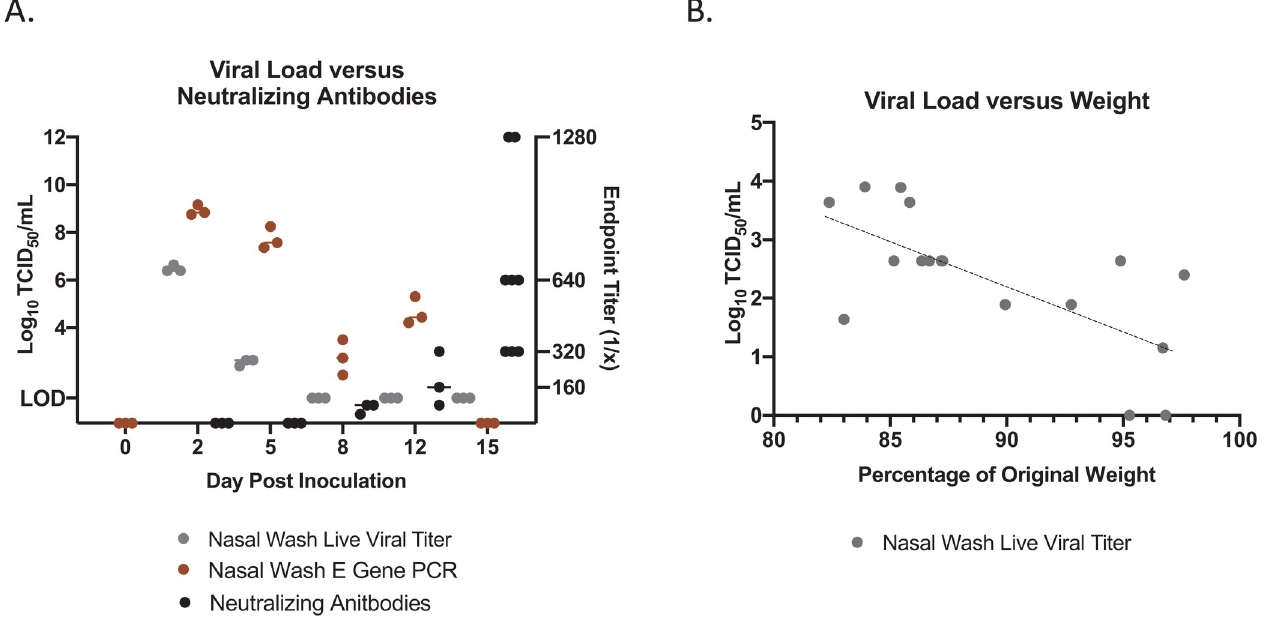
Fig 3. Viral shedding of SARS-CoV-2 increases with severity of clinical outcomes but diminishes as neutralizing antibodies are detectable in animal plasma. Nasal washes were collected to quantify virus by qPCR detection of the SARS-CoV-2 E gene (Brown) and expressed in TCID 50 /ml equivalents. Live viral load assays (Grey) were performed to quantify infectious virus. Infectious titers of the nasal washes were determined by tissue culture infectious dose titration assays and the resulting TCID 50 /mL was calculated using the Reed and Muench method. LOD = limit of detection for live viral load assays. Virus neutralization titers were determined by standard neutralization assays using plasma collected throughout the time course (Black) (A). Live viral titer in the nasal washes negatively correlated with weight loss on day 5 post infection. R-value = -0.68 (p-value = 0.00242) (B).